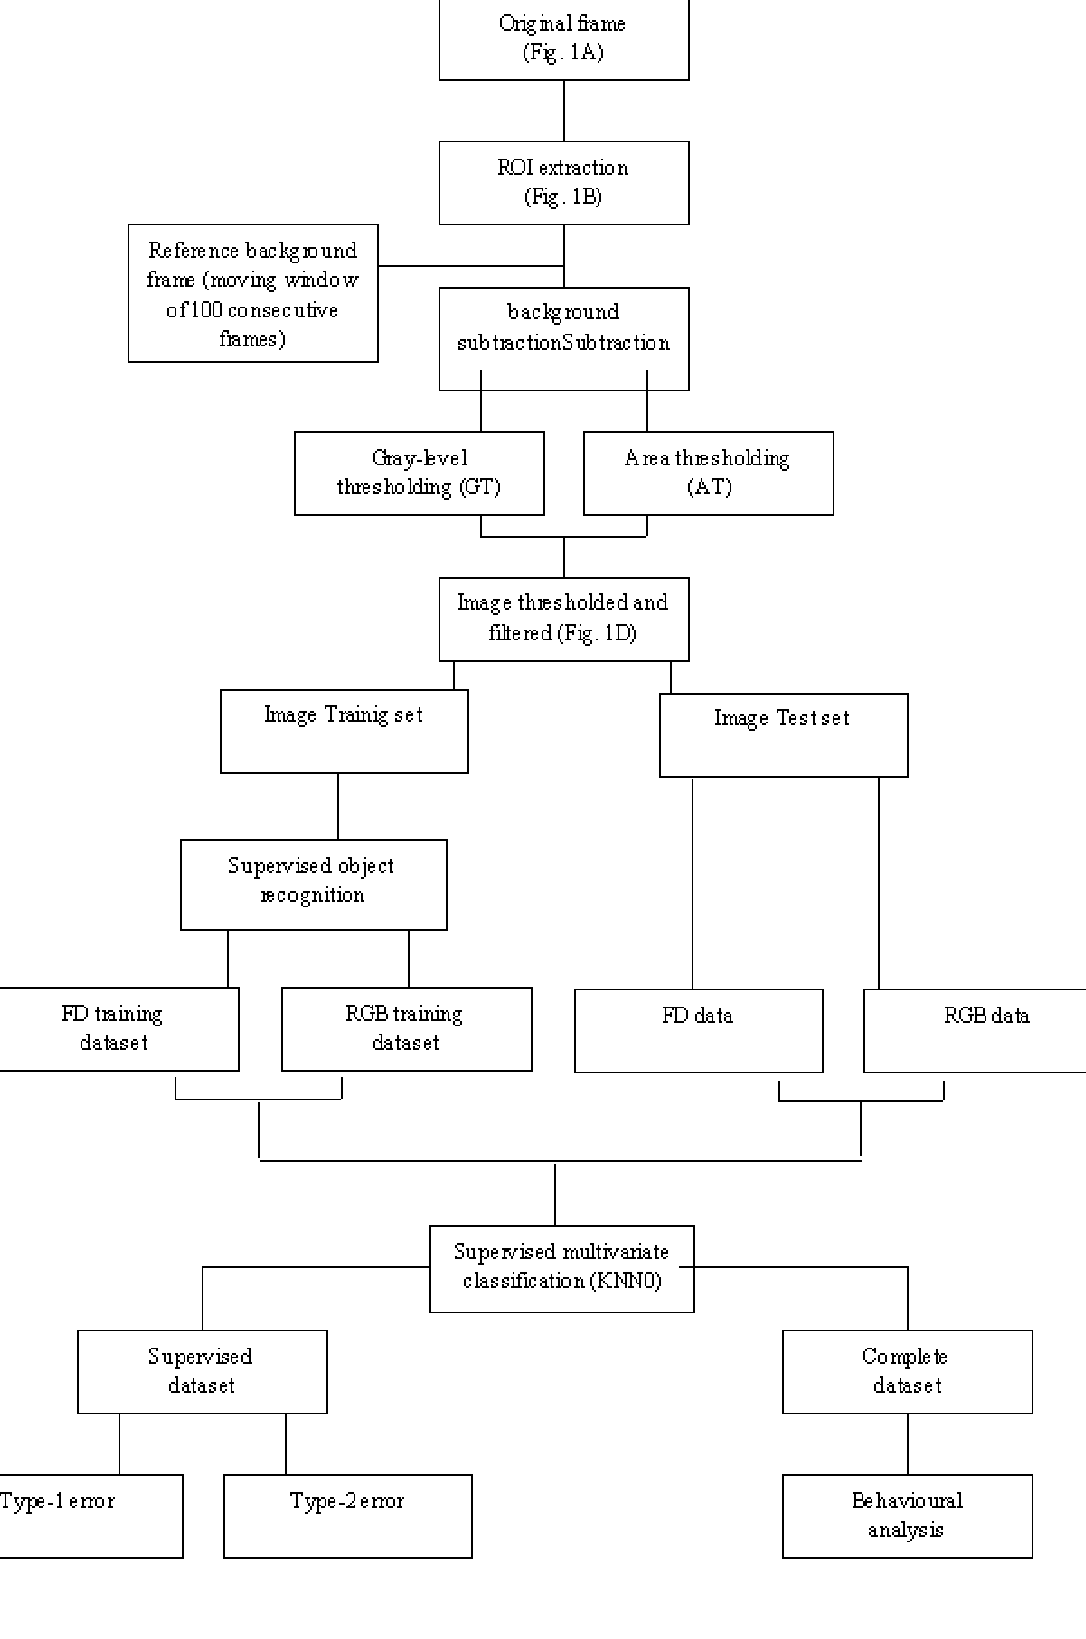
Figure 1. Flow chart representing the different steps involved in the automated